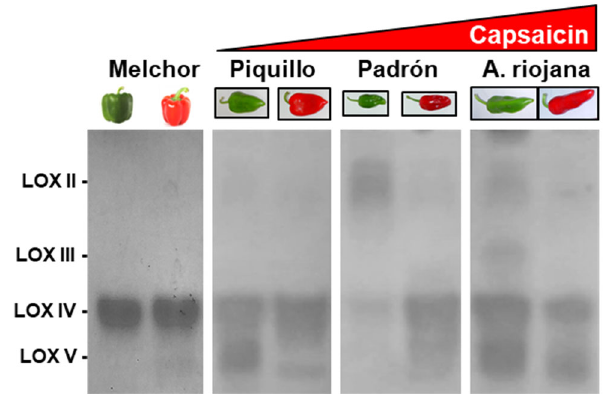
Figure 2. In ‐ gel lipoxygenase (LOX) isozyme activity assay in fruits from four pepper varieties including “Melchor”, “Padrón”, “Piquillo” and “Alegría riojana”. LOX catalyzes the oxygenation of polyunsaturated fatty acids (PUFA). Therefore, the relative content of FAs was studied by gas chromatography/mass spectrometry (GC/MS) as a percentage of fatty acid methyl esters (FAME). The most abundant FAs in the four fruit varieties in green and ripe stages were the PUFA linoleic (C18:2) and linolenic (C18:3) acids which correspond to the omega-6 and omega-3 FA families, respectively, as well as the saturated palmitic (C16) and stearic (C18) acids (Figure 3). It was noteworthy that C18:2 was the most abundant PUFA in green fruits of all varieties, and its content decreased after the fruits ripened, except in the Padrón variety, whose content was unaffected. On the other hand, C18:3 had an inverse behavior, since their content increased in red peppers as compared to green ones, except in the Padrón variety, in which the content was unaffected. Regarding C16 and C18, it was observed that during ripening, the linoleic and stearic acid content declined in Piquillo red fruits whereas linolenic acid increased.